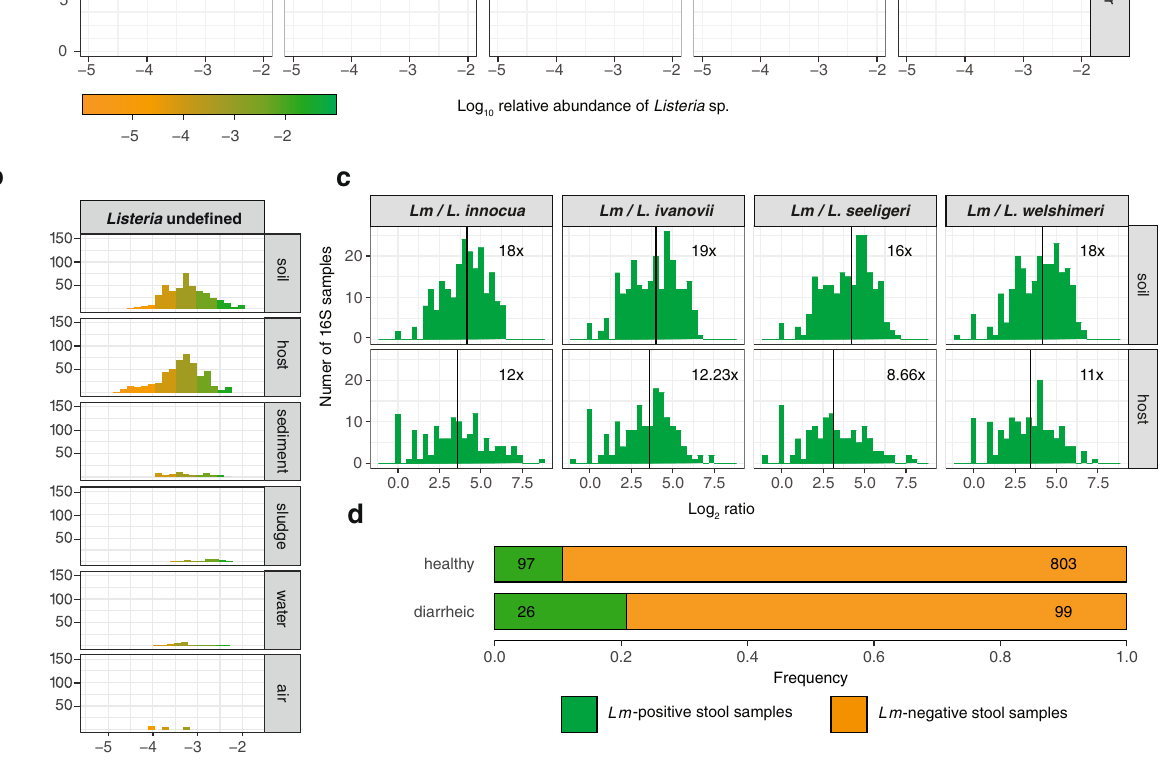
Fig. 2 Lm is more abundant than other Listeria species in all environments and Lm carriage is common in healthy individuals. a Same as Fig. 1a, normalised by category. b Relative abundance and prevalence of Listeria unde fi ned in 16S rRNA gene datasets in different environments. c Log 2 of ratio of Lm to each other evaluated Listeria species in samples where the species co-occurred. Vertical lines and numbers indicate the mean of the distribution. d Prevalence of Lm in human faecal samples from healthy ( n = 900) and diarrhoeic donors ( n = 125) from